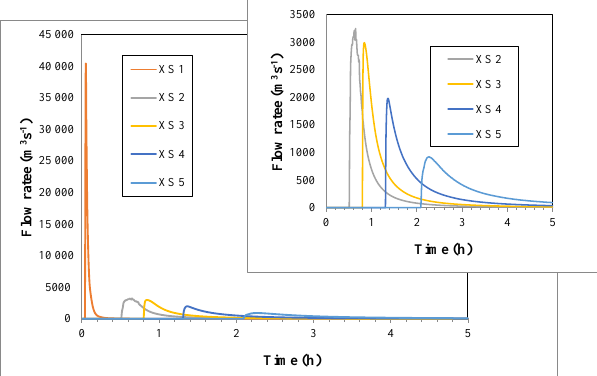
Figure 7. Flood hydrographs at 5 cross-sections downstream of Lake Palcacocha for the large avalanche and current lake level scenario. Inset shows results on a larger vertical scale for cross-sections 2-5.